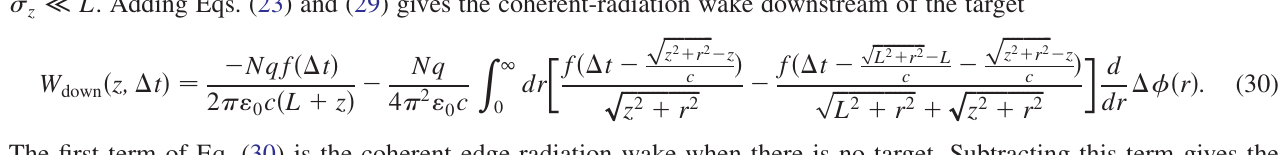
ffiffiffiffiffiffiffiffiffiffi p z 2 þ r 2 ffiffiffiffiffiffiffiffiffiffiffiffiffiffiffi